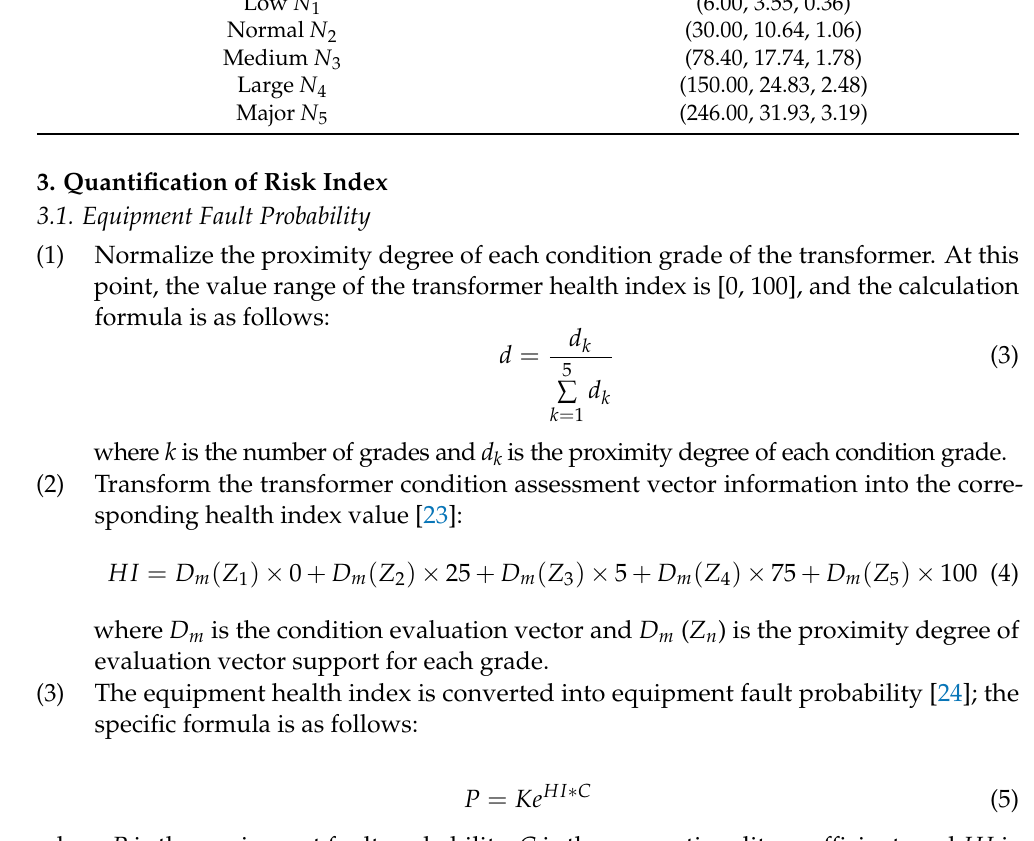
Table 1. Normal cloud model parameters of transformer risk grades. Risk